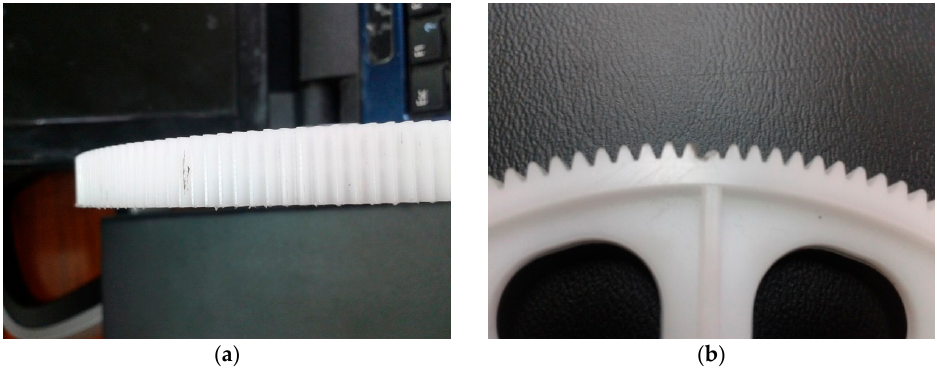
Figure 3 . ( a ) Faulty gear with scuffing; and ( b ) faulty gear with broken tooth. Figure 3. ( a ) Faulty gear with scuffing; and ( b ) faulty gear with broken